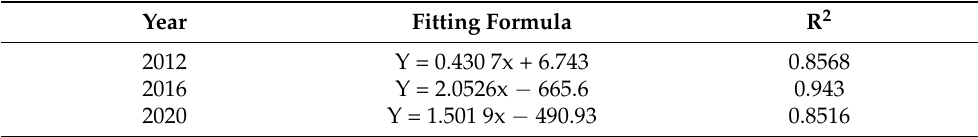
Table 1. Carbon emission simulation regression